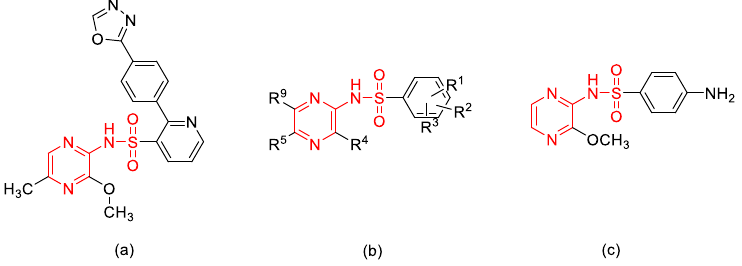
Figure 2. The chemical structure of ( a ) zibotentan, ( b ) halogenated N -(pyrazinyl)benzensulfonamides, and ( c ) sulfamethoxypyrazine (sulfalene).